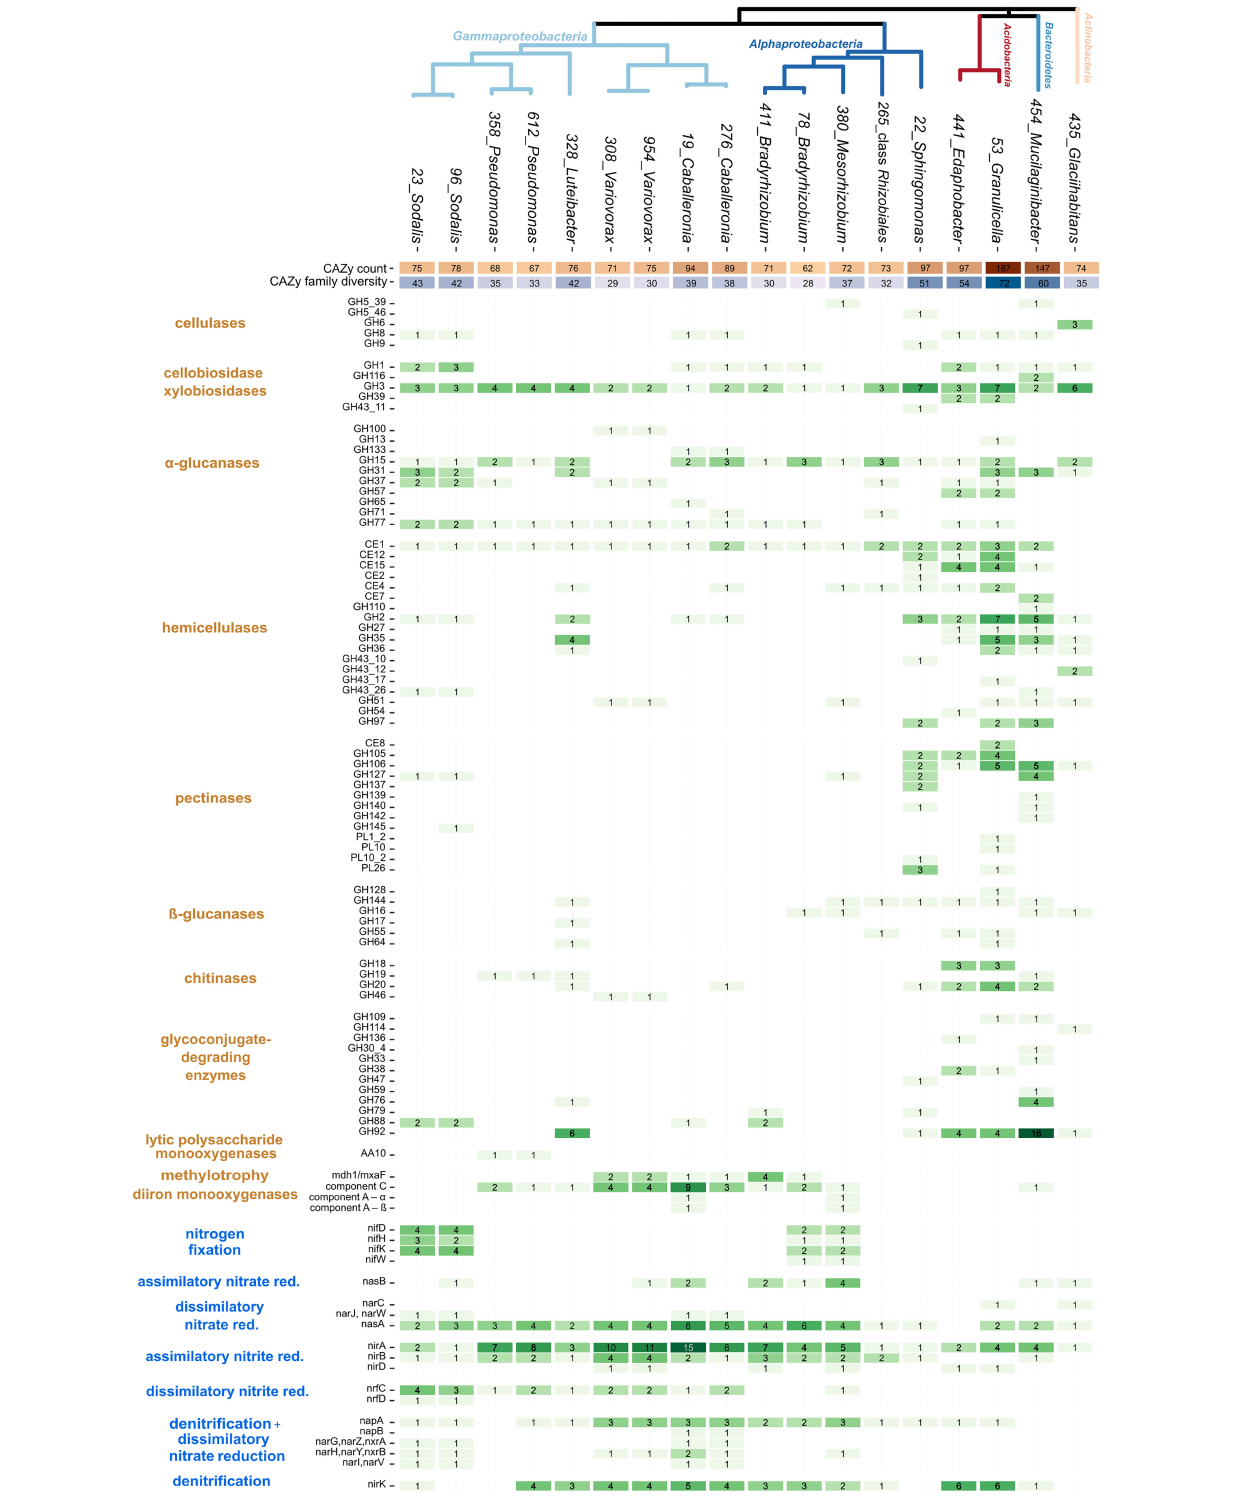
Frontiers in Microbiology |